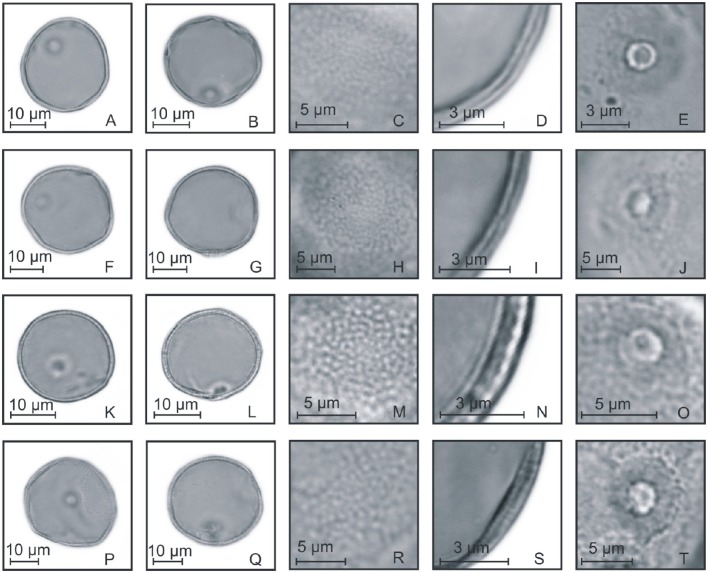
Pollen grains of the subfamilies Ehrarthoideae, Danthonioideae, and Chloridoideae. (A–E)
Leersia sp.: PV (A), EV (B), detail of ornamentation (C), detail of the thickness of the exine (D), and detail of the aperture (E); (F–J)
Danthonia montana: PV (F), EV (G), detail of ornamentation (H), detail of the thickness of the exine (I), and detail of the aperture (J); (K–O)
Eragrostis neesii: PV (K), EV (L), detail of ornamentation (M), detail of the thickness of the exine (N), and detail of the aperture (O); (P–T)
Chloris canterae: PV (P), EV (Q), detail of ornamentation (R), detail of the thickness of the exine (S), and detail of the aperture (T).